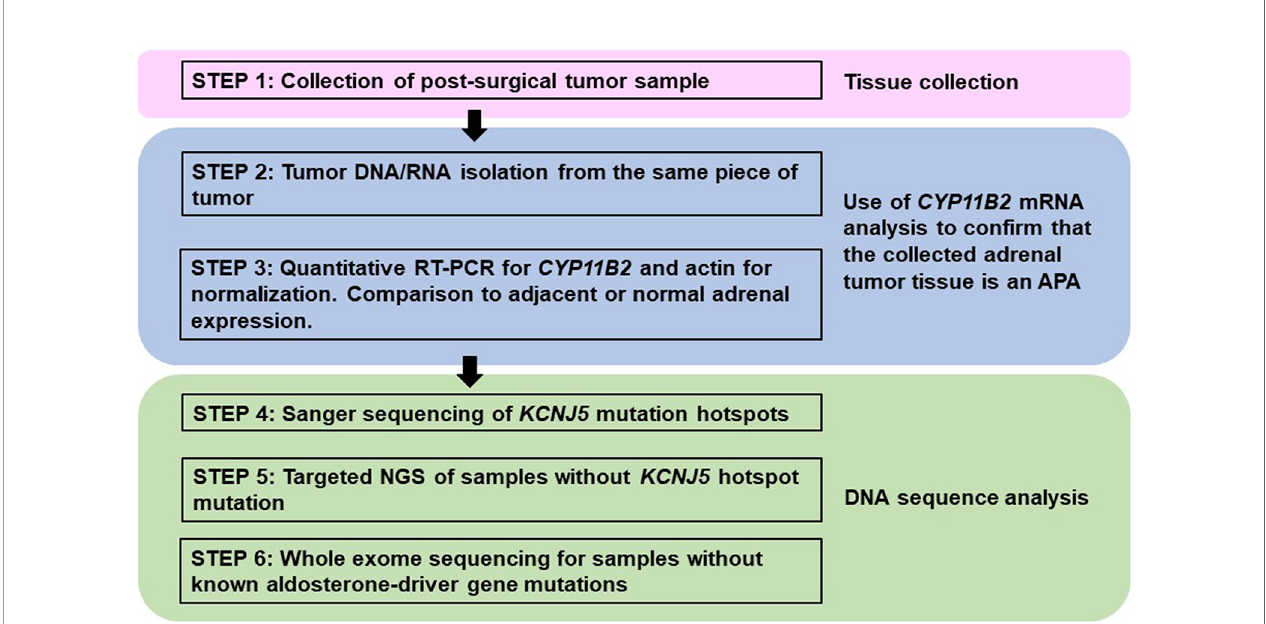
FIGURE 3 | Proposed method for processing fresh or frozen adrenal tumor tissue from patients with primary aldosteronism for mutational analysis. This approach varies from FFPE processing (Figure 1) by the method of tissue collection and the need to use CYP11B2 mRNA detection for con fi rmation of APA status. However, mutational analysis is similar using Sanger and/or next-generation sequencing to detect known and/or novel drivers of aldosterone production.